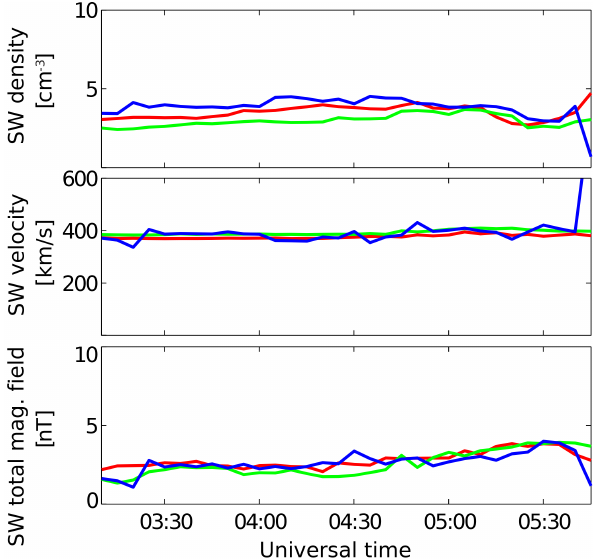
Figure 3. The magnetosheath density (top panel), the ion velocity (middle panel), and the magnetic field (bottom panel), which are observed by THEMIS on 1 August 2009, are presented in red. The best match for the data to the magnetosheath model for any initial choice of the solar wind boundary parameters was found for the magnetosheath model predictions, which are shown in blue.